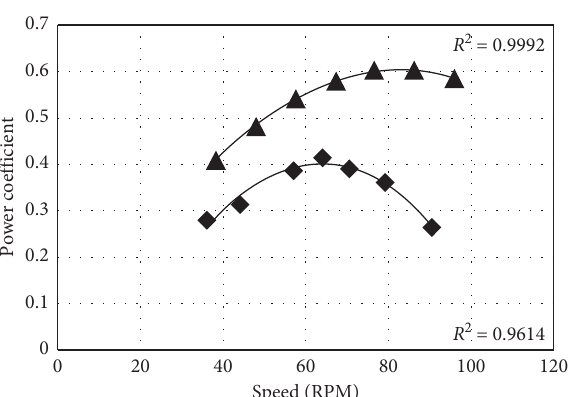
Figure 34: Runner 17 data points.